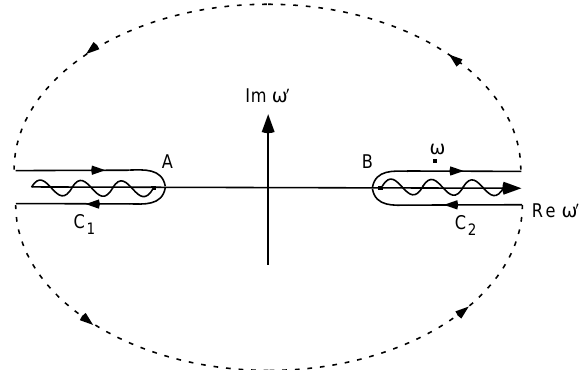
FIG. 9. Complex plane v 0 with the integration contours (cid:67) (cid:49) and (cid:67) (cid:50) . The path (cid:67) (cid:49) 1 (cid:67) (cid:50) can be closed by adding infinitely large semicircles shown by dashed lines. loop in Fig. 9 (with the cutoff frequency now 6 (cid:99) n (cid:110) rather than 6 (cid:99) m (cid:110) (cid:44) (cid:109) (cid:121) (cid:98) (cid:48) ). The only difference arises